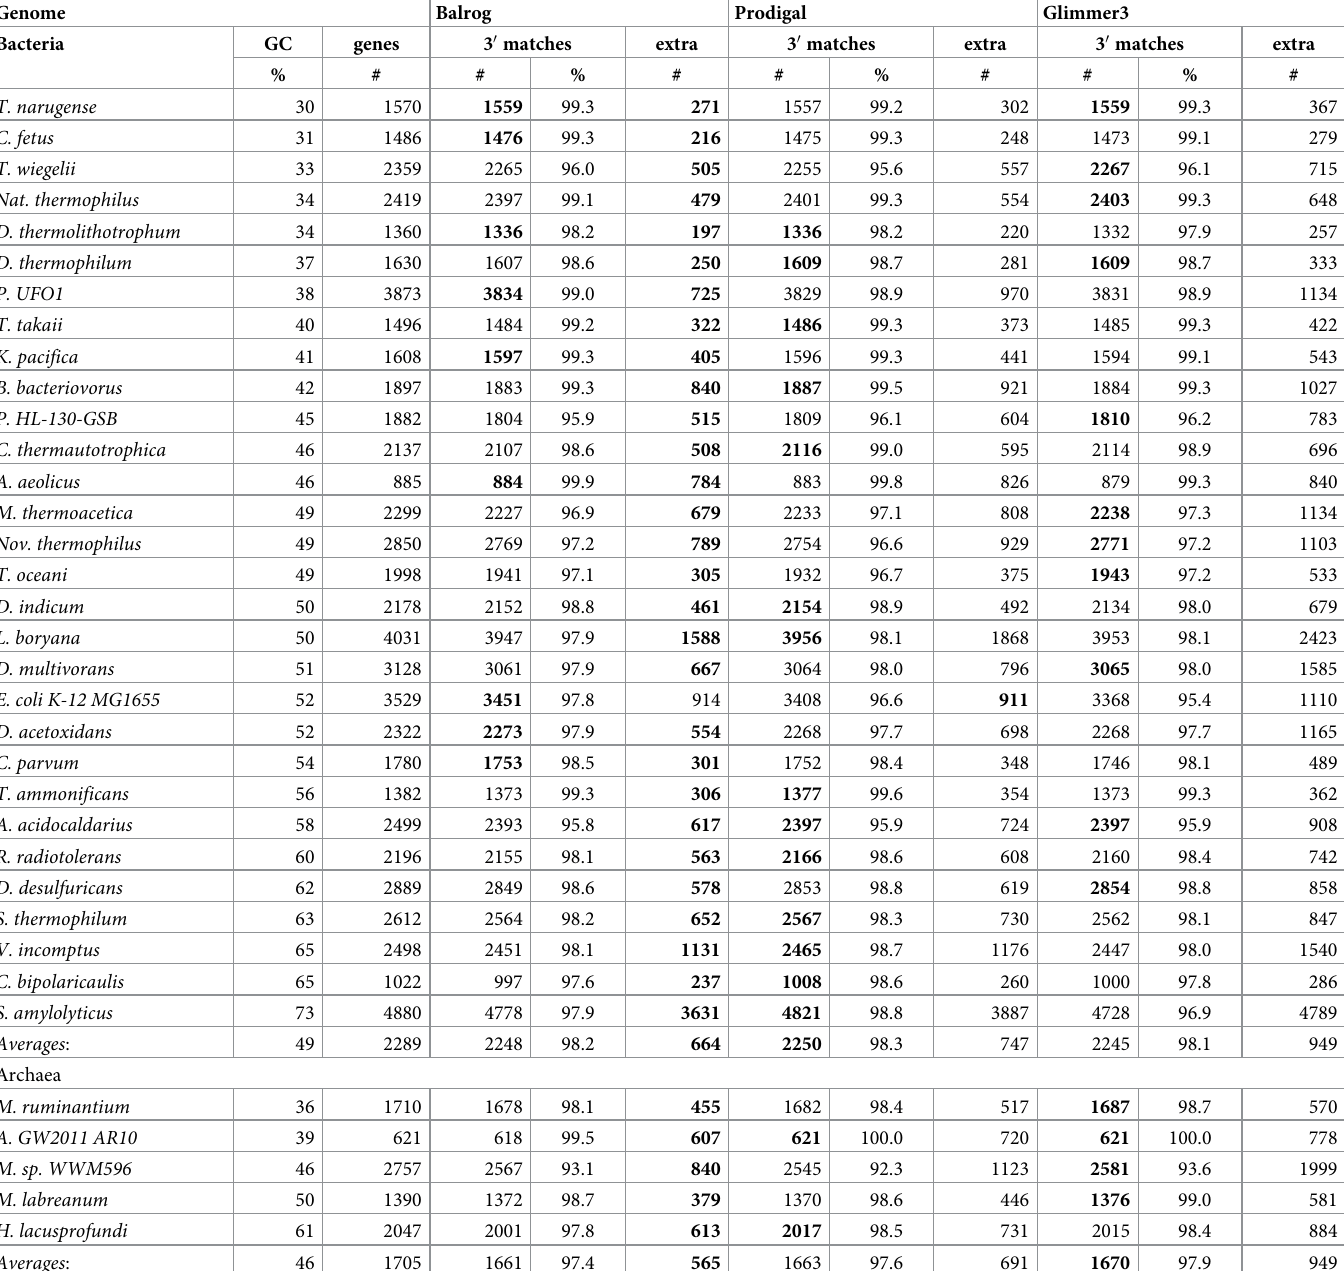
Table 1. Non-hypothetical gene prediction comparison.